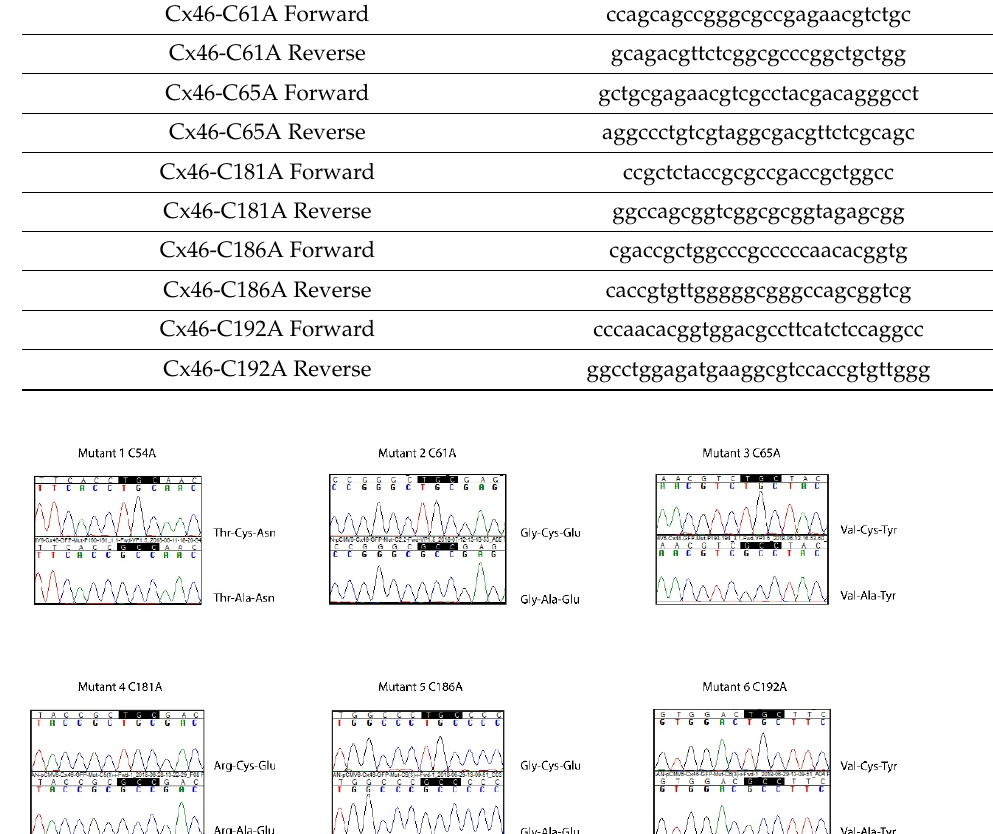
Figure 7. Sequencing results from Cx46 Cys mutants. cDNA plasmids containing the mutagenesis products were sequenced. For each panel, the upper electropherogram shows the sequence for human wild-type Cx46, and the bottom part shows the sequence obtained for the mutants.